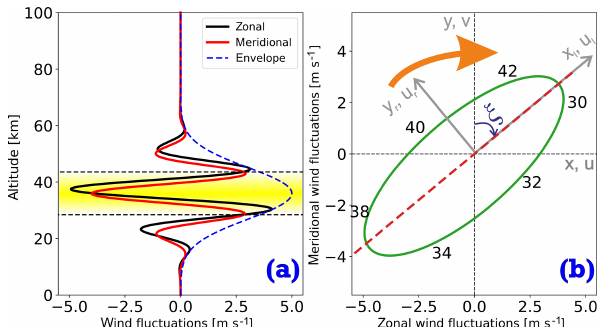
Figure 1. Schematics of the method. (a) Altitude profile of horizon- tal velocity fluctuations. Blue dashed line demonstrates an envelope. Colored area marks altitude range of one wavelength where wave amplitude is most significant ( [ z 0 − λ z / 2 ,z 0 + λ z / 2 ] ). (b) Hodo- graph ellipse of GW horizontal velocity variations taken from alti- tude range marked in plot (a) . Dashed line shows major axis of el- lipse, which is a propagation direction of the wave. Numbers around ellipse are altitudes. These schematics have a clockwise rotation.